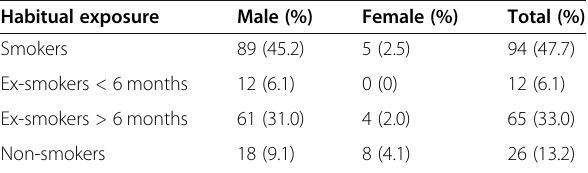
Table 9 Distribution of habitual exposure with respect to